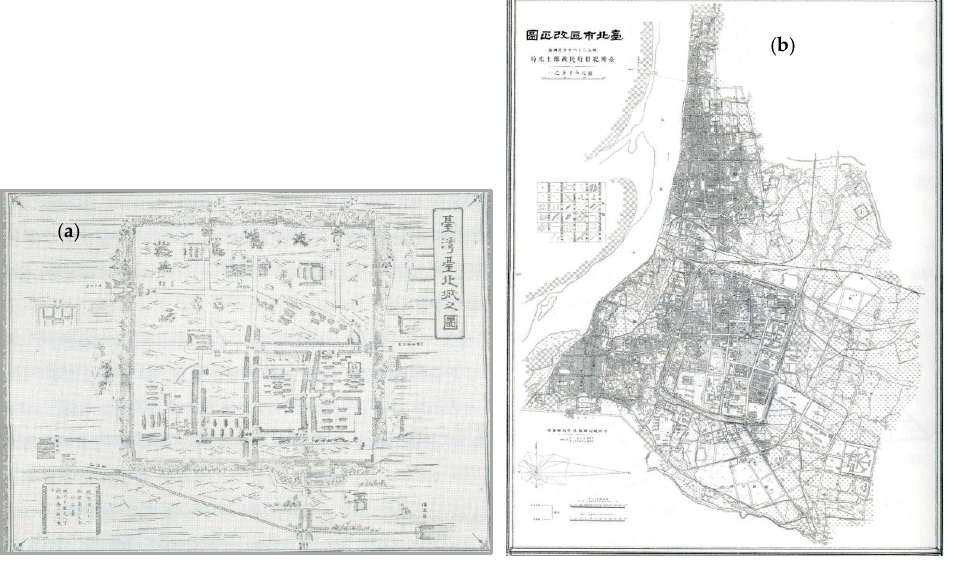
Figure 4. ( a ) Qing dynasty-style Taipei Prefecture, 19th century. ( b ) Modern expanded city of Taipei, 1905 [24].